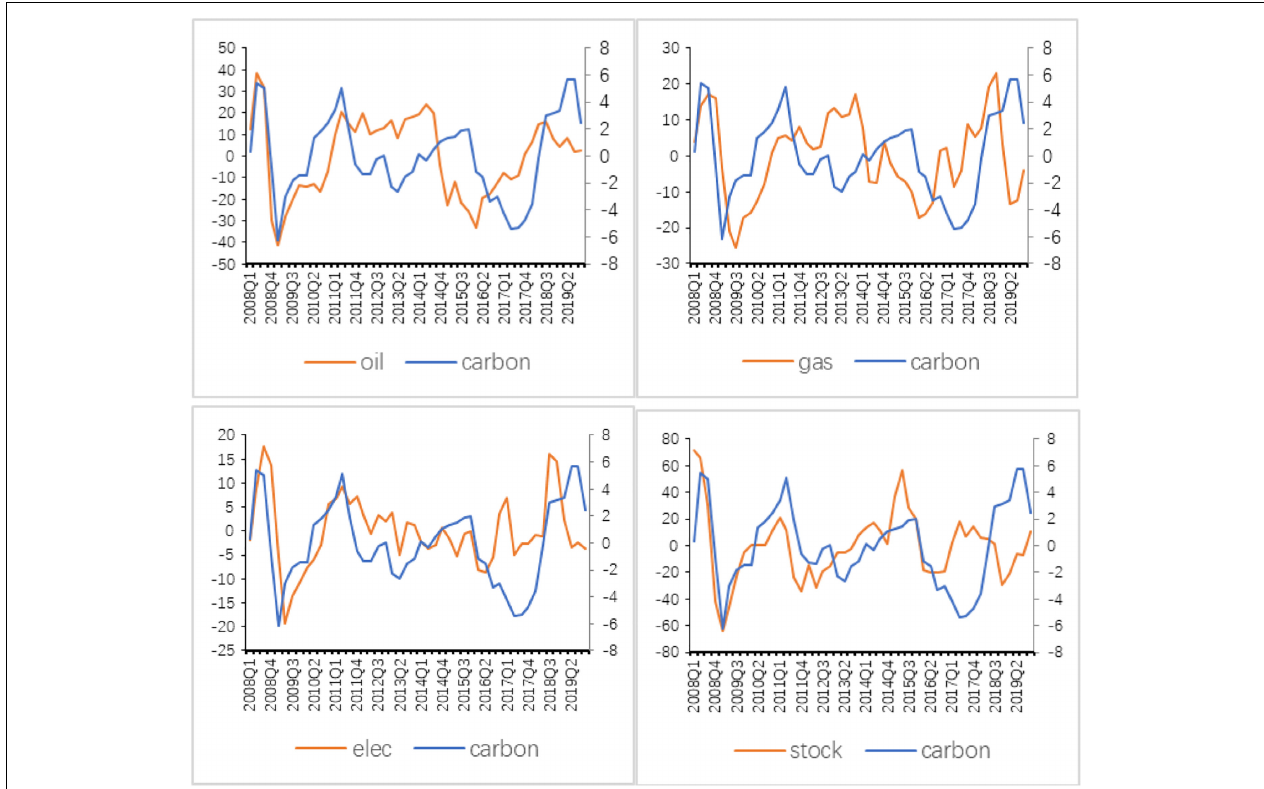
FIGURE 1 | Carbon price (thick solid line) and key price drivers (thin solid line) periodic series.